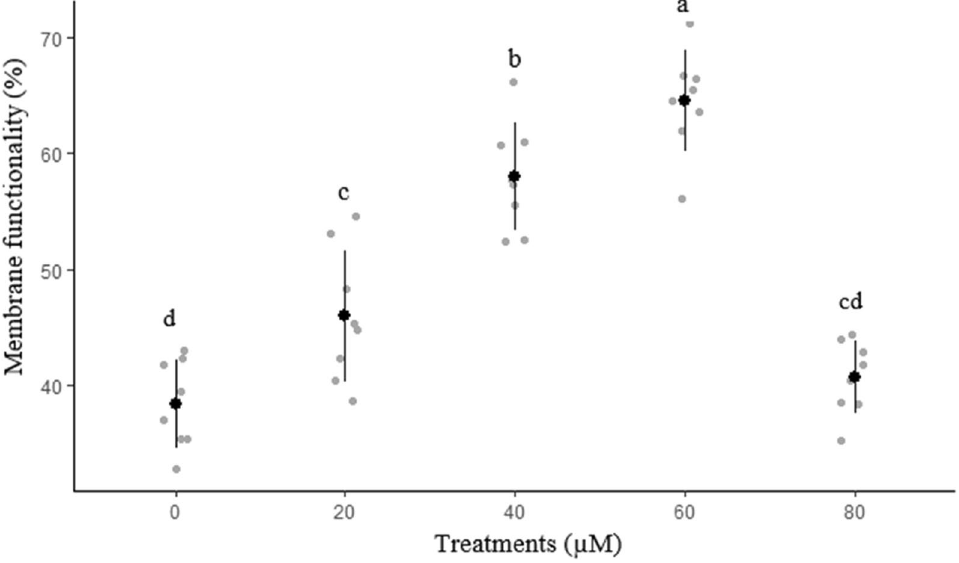
Figure 2. Effect of different levels of rosiglitazone on membrane functionality of ram sperm.